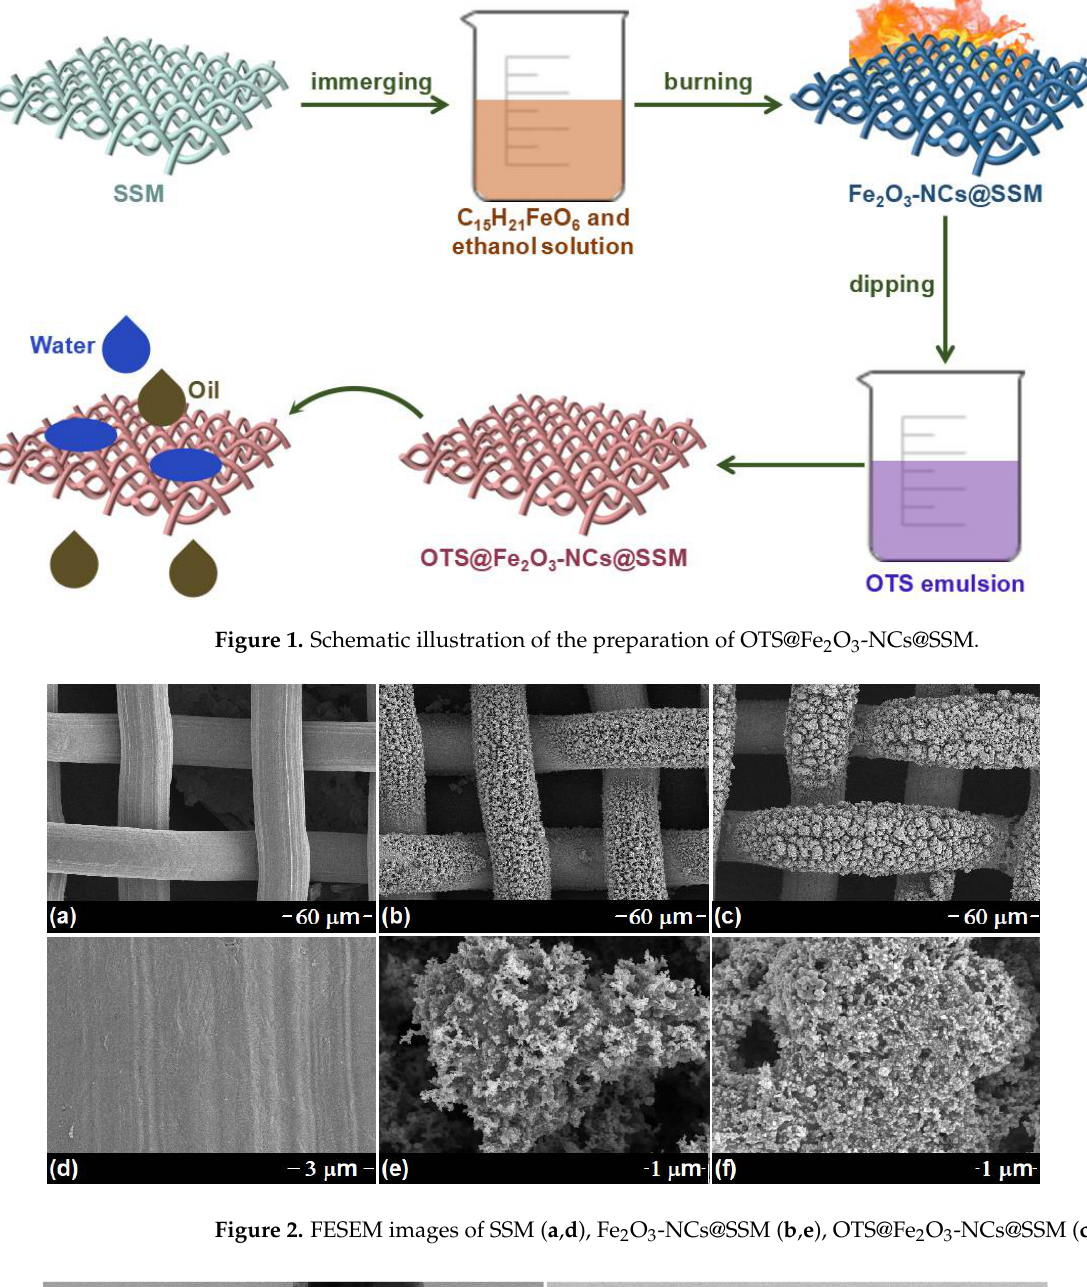
Figure 1. Schematic illustration of the preparation of OTS@Fe 2 O 3 -NCs@SSM.